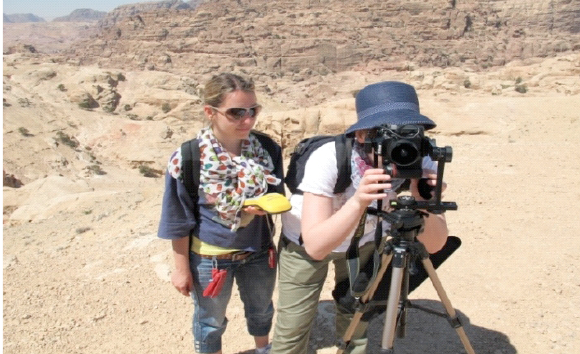
Figure 4: georeferenced photography to record the boundary points.